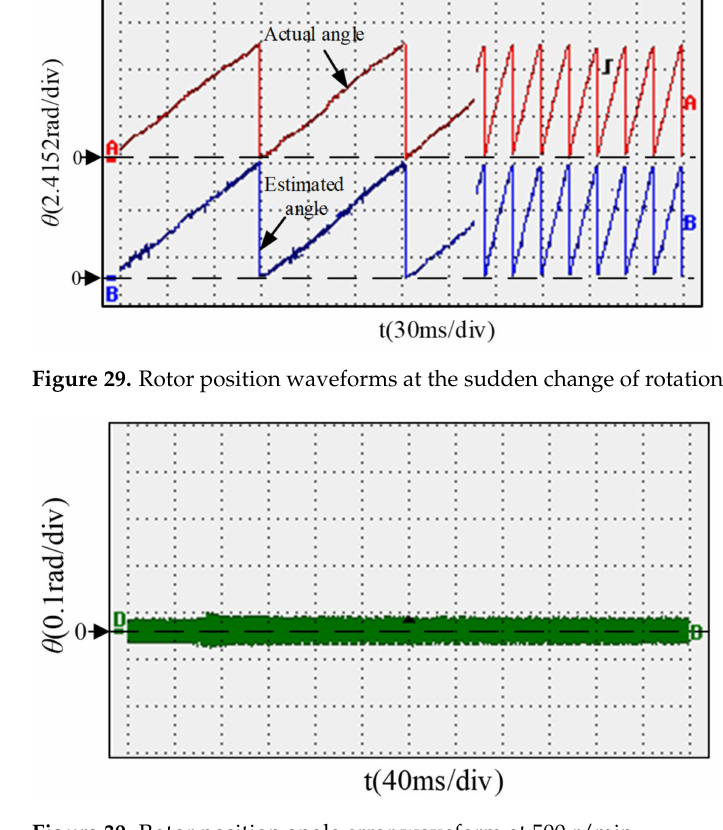
Figure 30. Rotor position angle error waveform at 500 r/min.